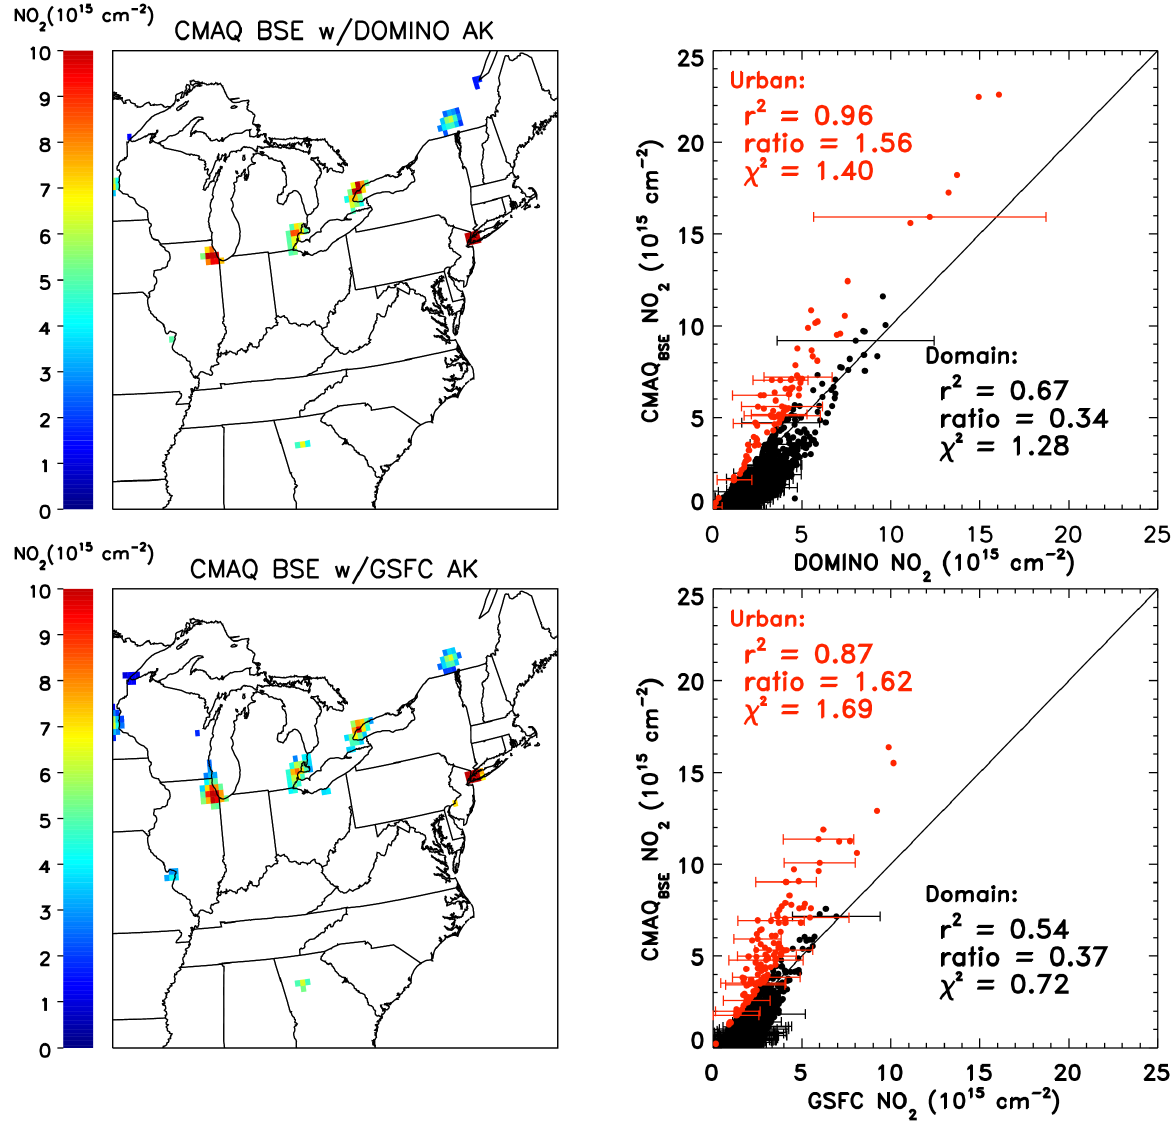
Figure 3. The same model output as Fig. 2 except results are only shown for regions where the simulations are at least 25% greater than observations (left panels). This clearly shows that model is biased high over urban regions indicated by the red points in the scatter plots (right